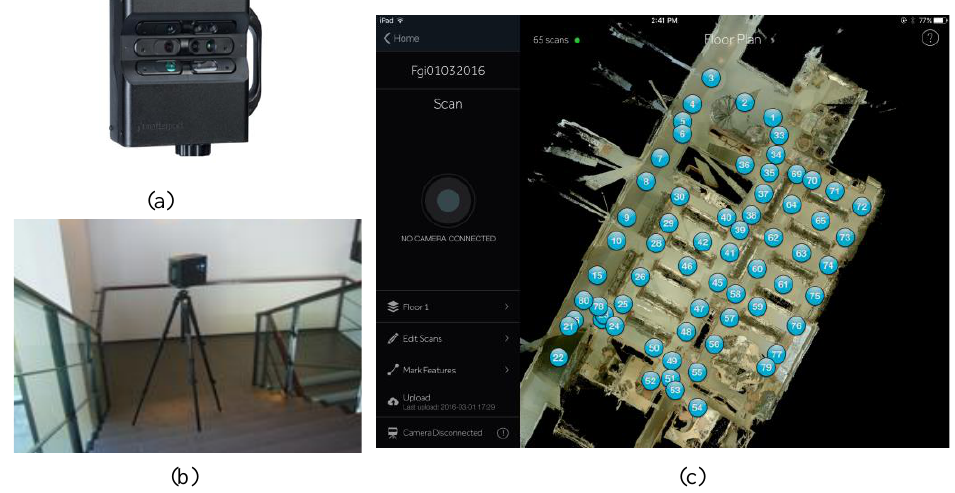
Figure 1. ( a ) Matterport 3D camera; ( b ) Matterport in operation for mapping FGI indoor environment; ( c ) Top view of a 3D model created by Matterport with multiple scans from the test site. The number of needed scans is illustrated in the